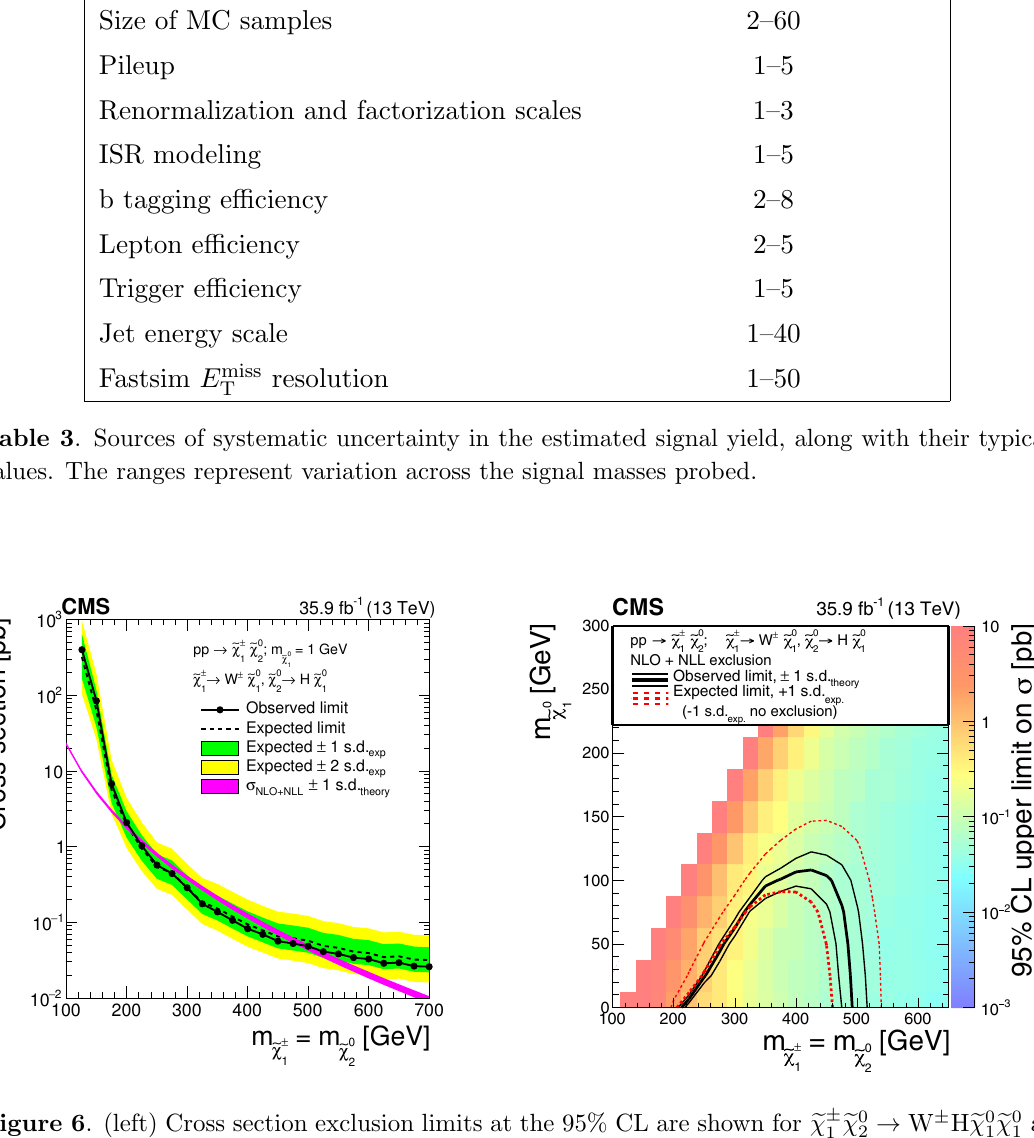
Figure 6 . (left) Cross section exclusion limits at the 95% CL are shown for a function of m , assuming m = 1 GeV. The solid black line and points represent the observed (cid:6) e (cid:31) 0 1 e (cid:31) 1 exclusion. The dashed black line represents the expected exclusion, while the green and yellow bands indicate the (cid:6) 1 and 2 standard deviation (s.d.) uncertainties in the expected limit. The magenta line shows the theoretical cross section with its uncertainty. (right) Exclusion limits at the 95% CL in the plane of m and m . The area below the thick black (dashed red) curve (cid:6) e (cid:31) 0 1 e (cid:31) 1 represents the observed (expected) exclusion region. The thin dashed red line indicates the +1 s.d. exp. experimental uncertainty. The -1 s.d. exp. line does not appear as no mass points would be excluded in that case. The thin black lines show the e(cid:11)ect of the theoretical uncertainties ( (cid:6) 1 s.d. theory ) on the signal cross